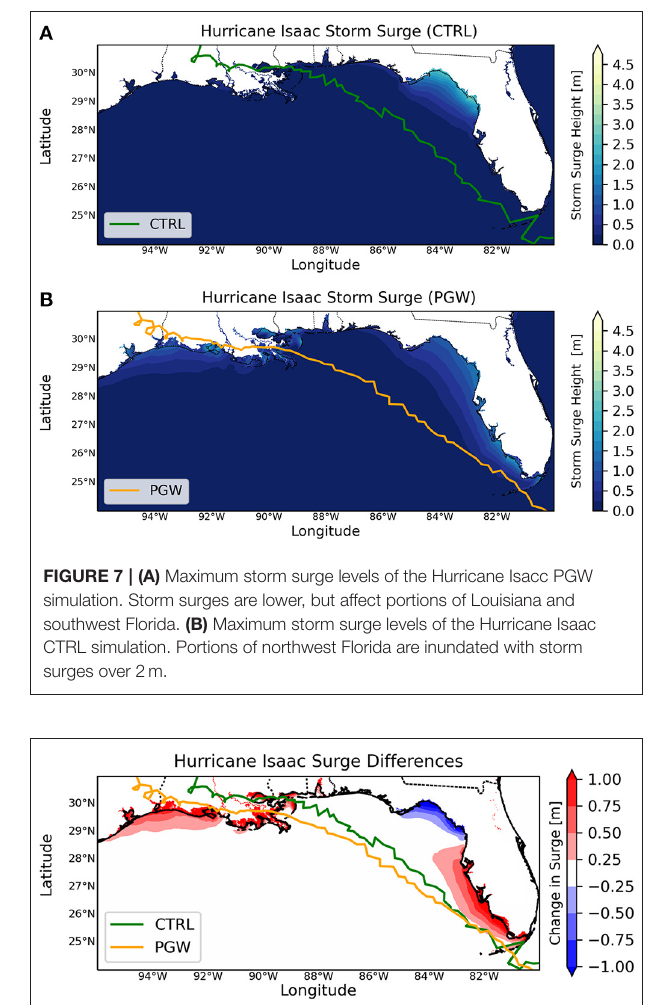
FIGURE 8 | Difference (PGW-CTRL) between maximum storm surge levels over the 21st century for Hurricane Isaac. The storm tracks for the CTRL (green) and PGW (orange) simulations are also